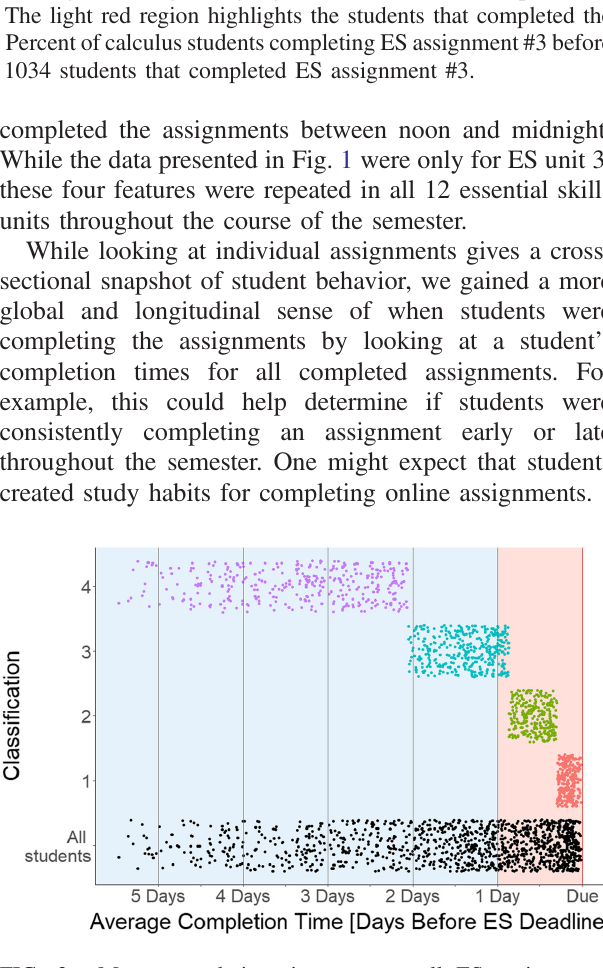
FIG. 2. Mean completion times across all ES assignments (jittered), split by the latent profile analysis classification groups 1, 2, 3, and 4 in red, green, blue, and purple, respectively. Each dot represents the mean completion time for one student. The black dataset represents the entire sample of students. The light blue region highlights the students that on average completed the essential skills assignments earlier than one day before the deadline. The light red region highlights the students that on average completed the essential skills assignment within the final 24 h before the deadline, which is at 11:59